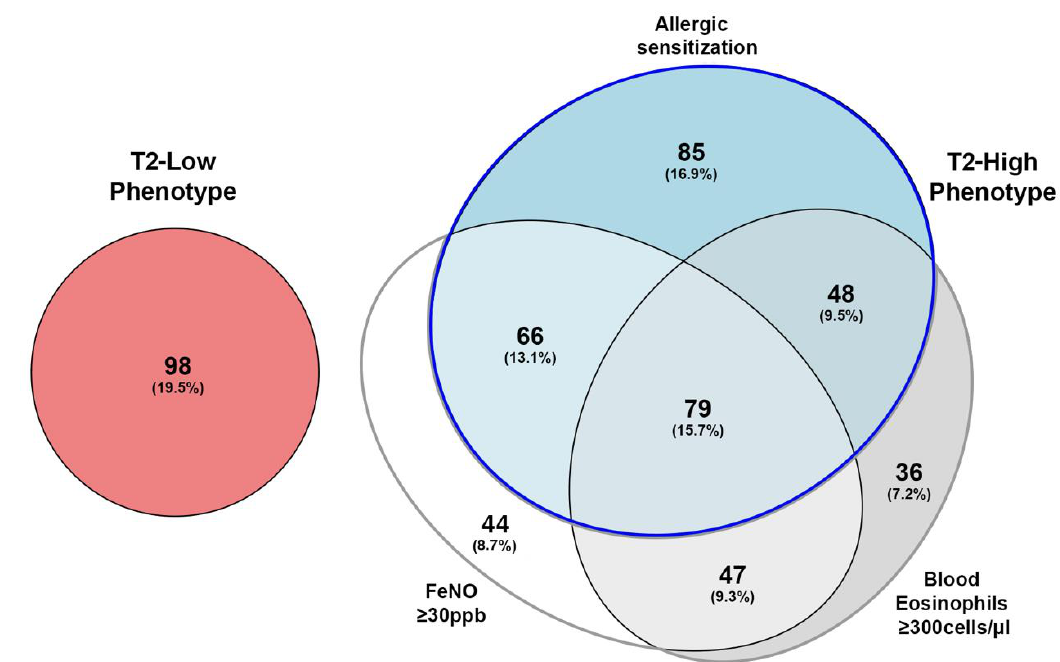
Figure 1. Area-proportional Euler Diagrams of the type 2 biomarker positivity in the type 2 phenotypes, including patients during biologic treatment. The “triple negative” T2-low phenotype is represented in red; in the T2-high phenotype, presence of allergic sensitization is represented in azure; blood eosinophils ≥ 300 cells/µL is reported in grey; F E NO ≥ 30 ppb is colored in white; the presence of multiple T2 biomarkers is reported with the overlap of the respective biomarker ovals. The blue line delimits the T2-high allergic phenotype, while the gray line delimits the T2-high non-allergic phenotype.